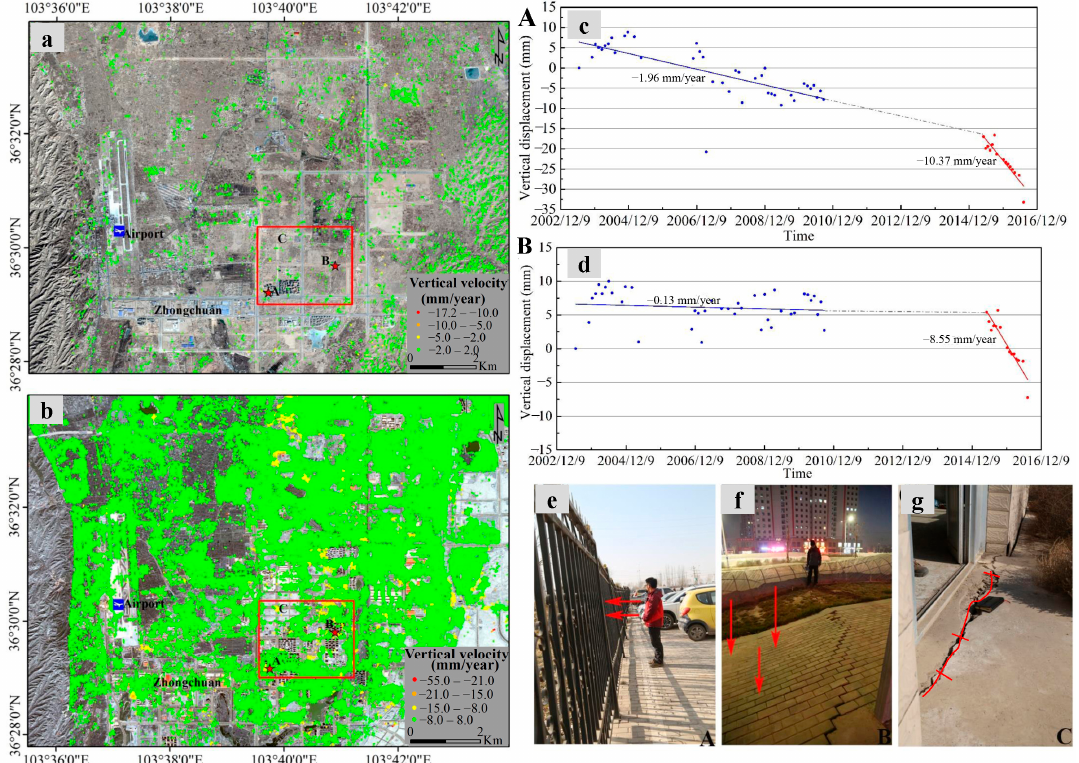
Figure 6. Typical subsidence observed in the main urban area located in the Central sector: ( a ) Average 2003–2010 velocity map; the PS points were superimposed on the Google Earth image obtained on 3 March 2013. ( b ) Average 2015–2016 velocity map; the CTs were superimposed on the GF-1 satellite image acquired on 17 October 2016. Red stars in ( a , b ) indicate the location of the PSs and CTs selected, respectively. ( c , d ) Vertical displacement time-series and corresponding linear rates of subsidence. Envisat (blue) and Sentinel-1A (red) time series are shown. The gap between 2011 and 2014 was filled by a prediction trendline (grey dashed line in ( c , d )). Images of: ( e ) fence tilt; ( f ) sidewalk subsidence; and ( g ) foundation